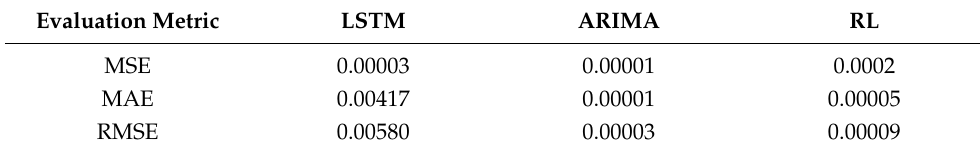
Table 5. MSE, MAE, and RMSE values for the predictive models